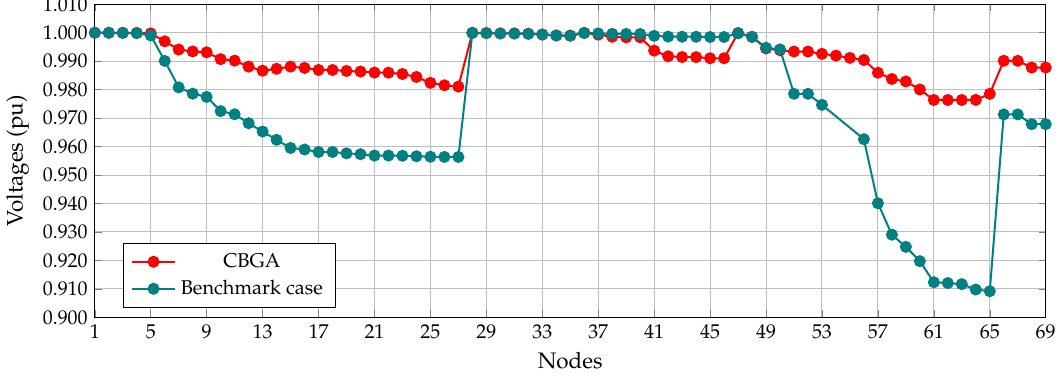
Figure 17. Voltage profiles in the 69-node meshed test